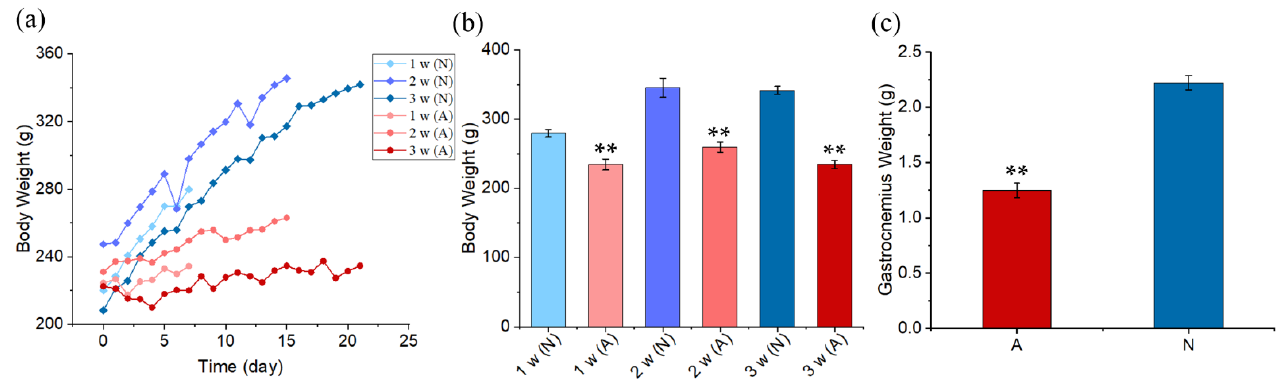
Figure 1. Body weight and gastrocnemius weight in a 21-day tail suspension test. ( a ) A 21-day continuous body weight change. ( b ) The body weights of the A group and the N group after 1 week, 2 weeks, and 3 weeks. ( c ) Gastrocnemius weights of the A group and the N group on day 21. The data are expressed as mean ± SE ( n = 5 in each group), ** p < 0.01 vs. N group in the same week.